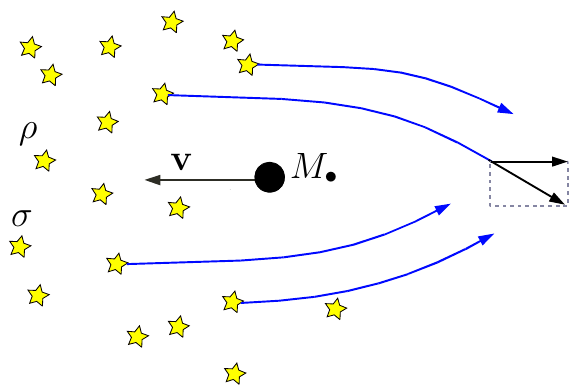
Fig. 16 In the reference frame of the encounter I depict a massive interloper, a stellar-mass black hole, traversing a sea of lighter stars which are deflected by it. The velocity vector of the stellar-mass black hole is bearely modified (at least in direction) by the deflections, because they cancel out on average